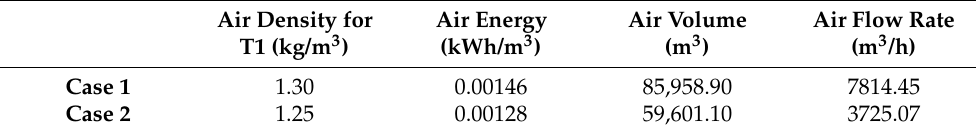
Table 8. Air density, air energy, air volume and air flow rate required for each of ASHP systems.